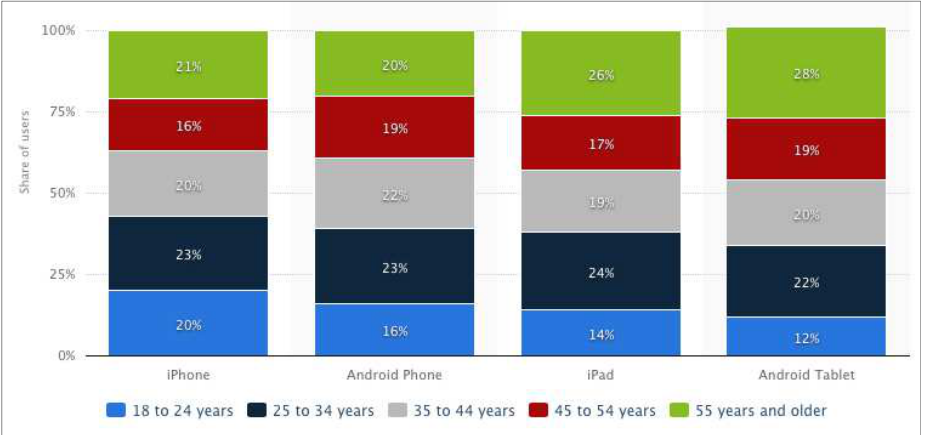
Figure 1 – Distribution of mobile app platform audiences in the United States as of June 2014, by age group (ComScore,